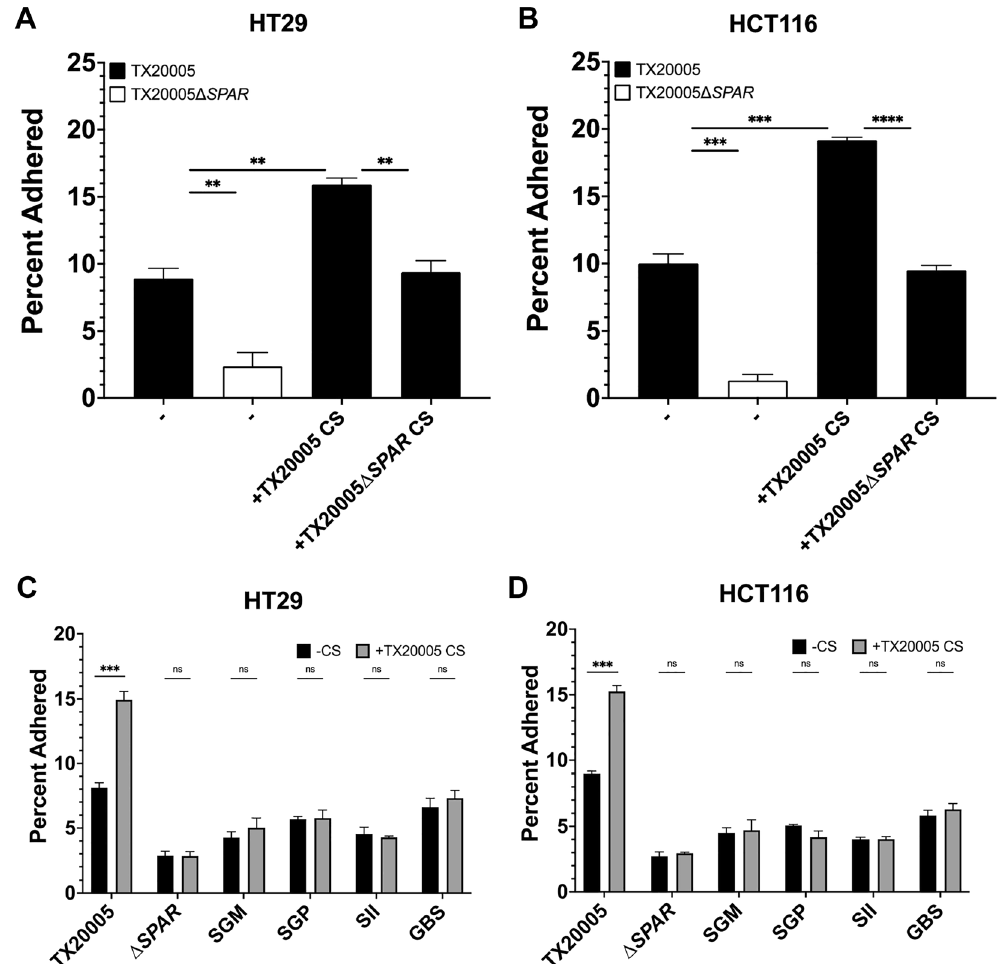
only or in the presence of CS from TX20005 or TX20005 ΔSPAR for 1 h. HT29 ( C) and HCT 116 ( D ) cells were seeded at a density of 1 × 10 6 cells per well and incubated with various bacteria (MOI = 10) for 1 h. SGM,